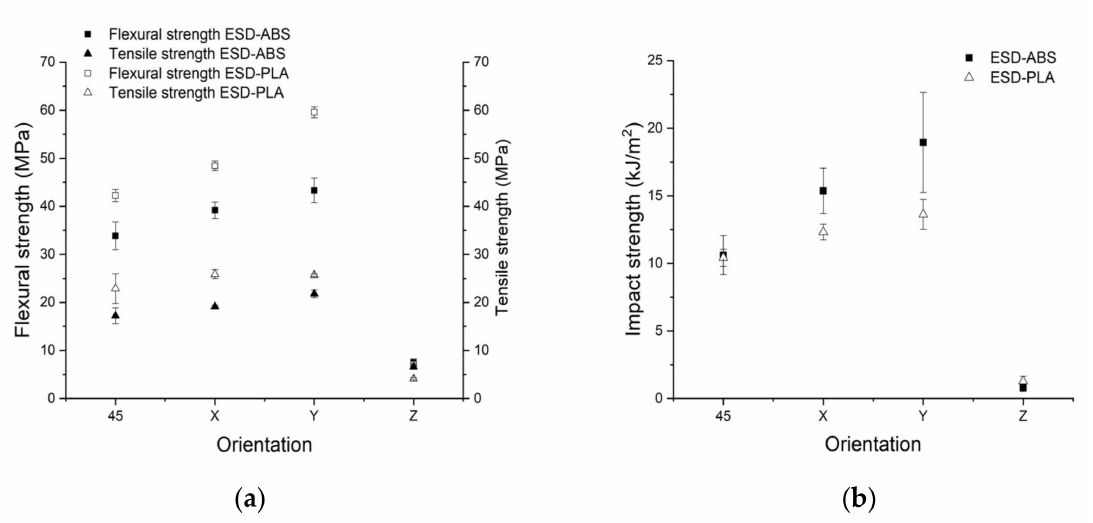
Figure 4. The results of dynamical and static mechanical testing. The graph on the left ( a ) demonstrates the results of tensile test strength and the 3-point bending test; ( b ) indicates the results of the Charpy Impact test in each printing orientation. Mean values with the standard deviation are